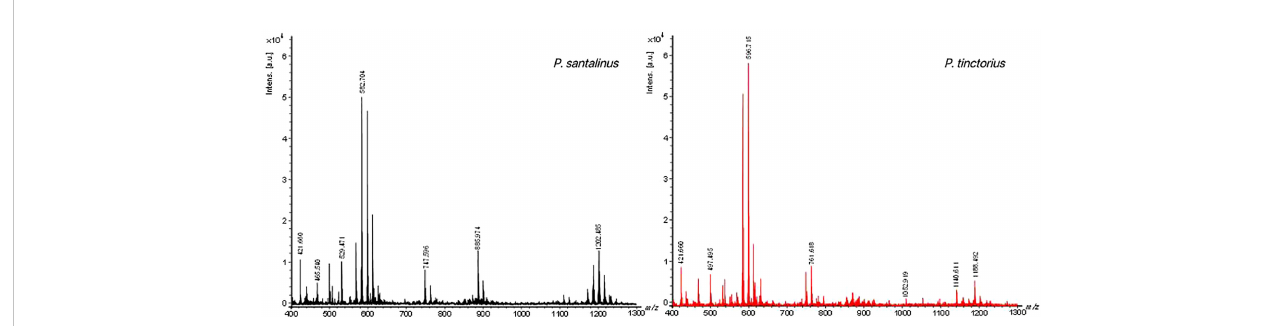
FIGURE 2 MALDI-TOF mass spectra of wood slices of P. santalinus (black) and P. tinctorius